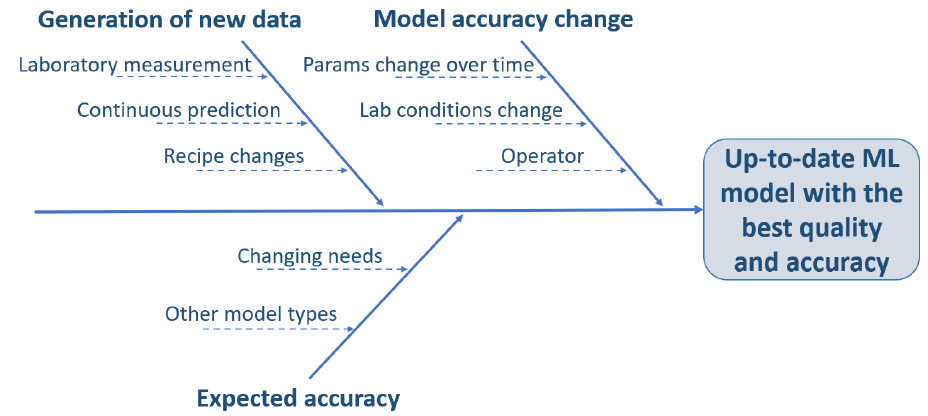
Figure 9. Ishikawa diagram related to the development of ML models. The accuracy and applicability of the ML model can be influenced by the three main factors, which are affected by two or three